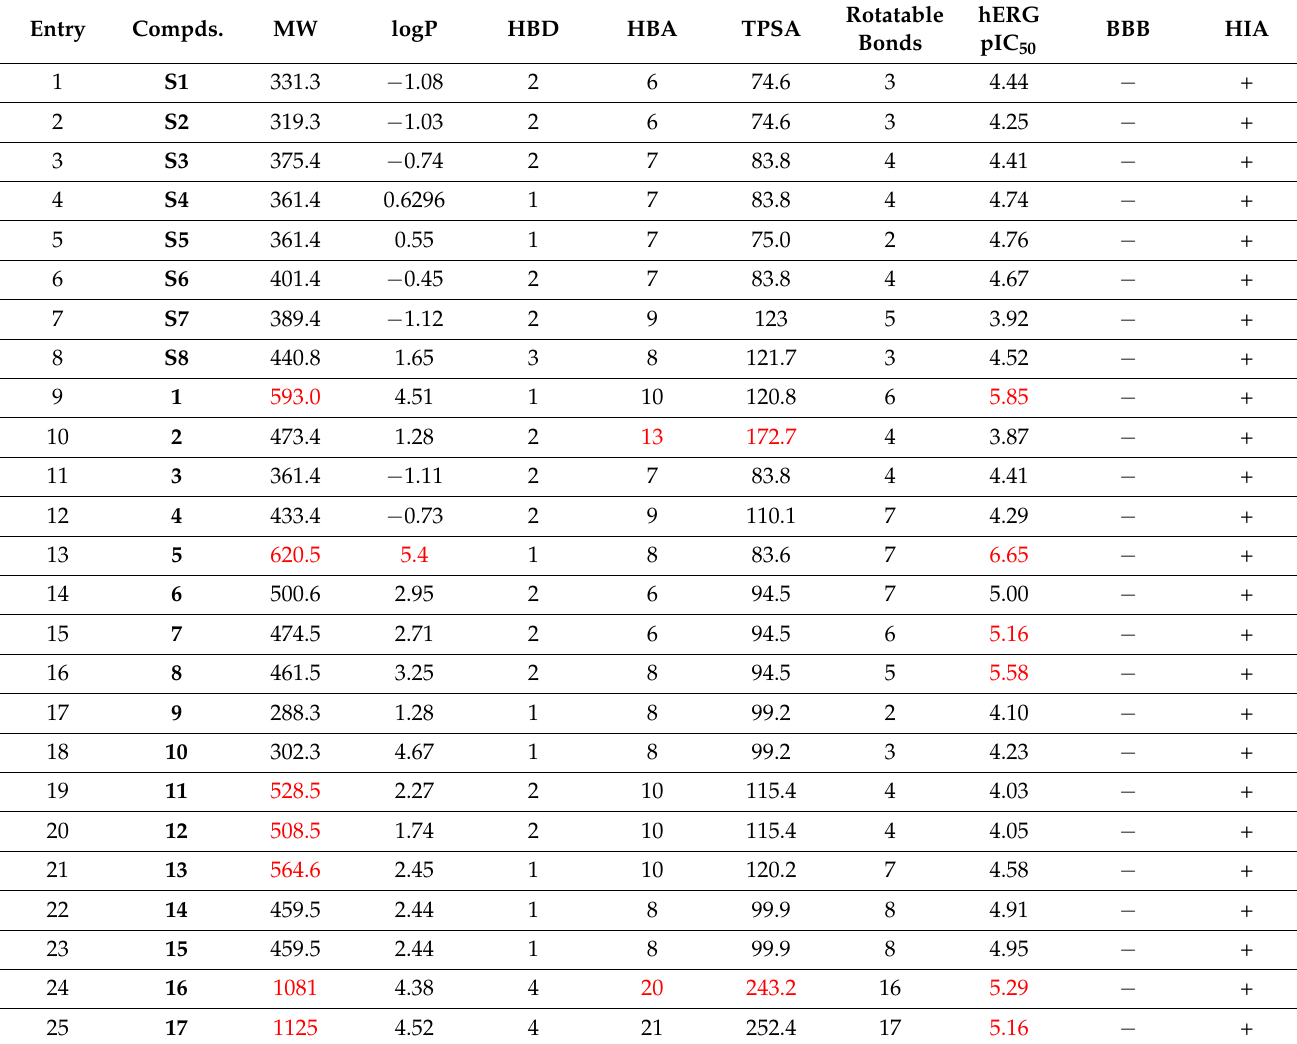
Table 4. Predicted drug-like properties of the quinolones in this